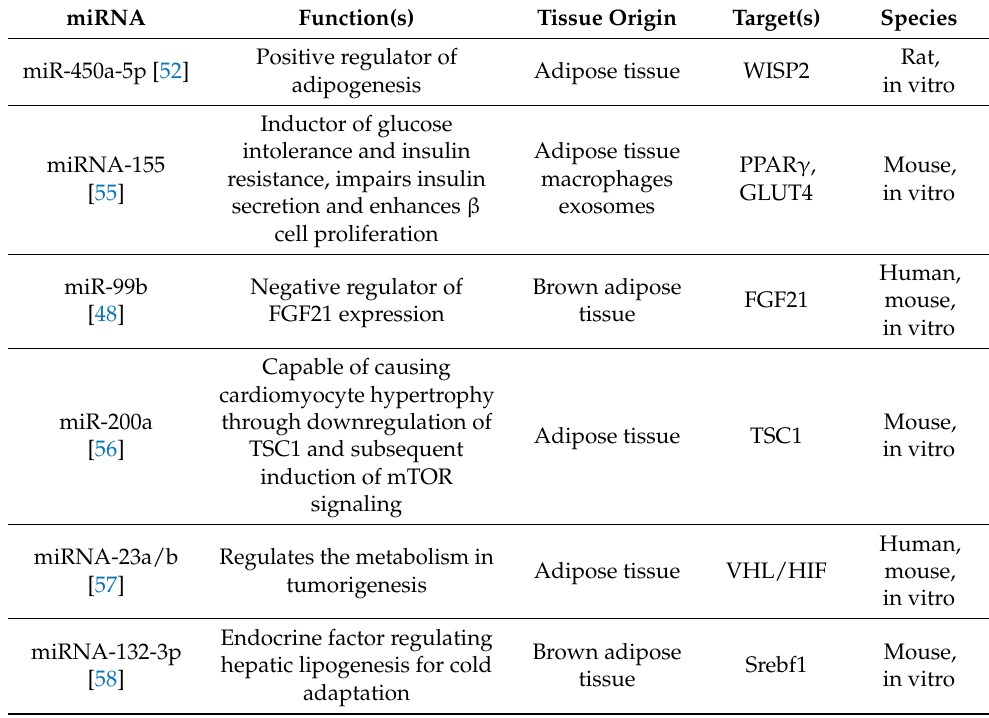
Rat, Adipose tissue WISP2 in vitro Adipose tissue PPAR γ , Mouse, macrophages GLUT4 in vitro exosomes Human, Brown adipose FGF21 mouse, tissue in vitro Mouse, Adipose tissue TSC1 in vitro Human, Adipose tissue VHL/HIF mouse, in vitro Brown adipose Mouse, Srebf1 tissue in